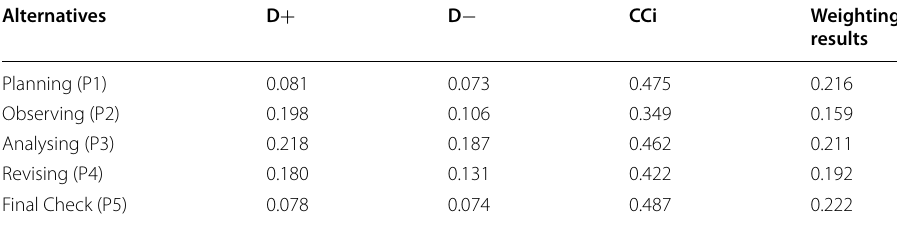
Table 9 Analysis results for the phase 2 of QFD Alternatives D